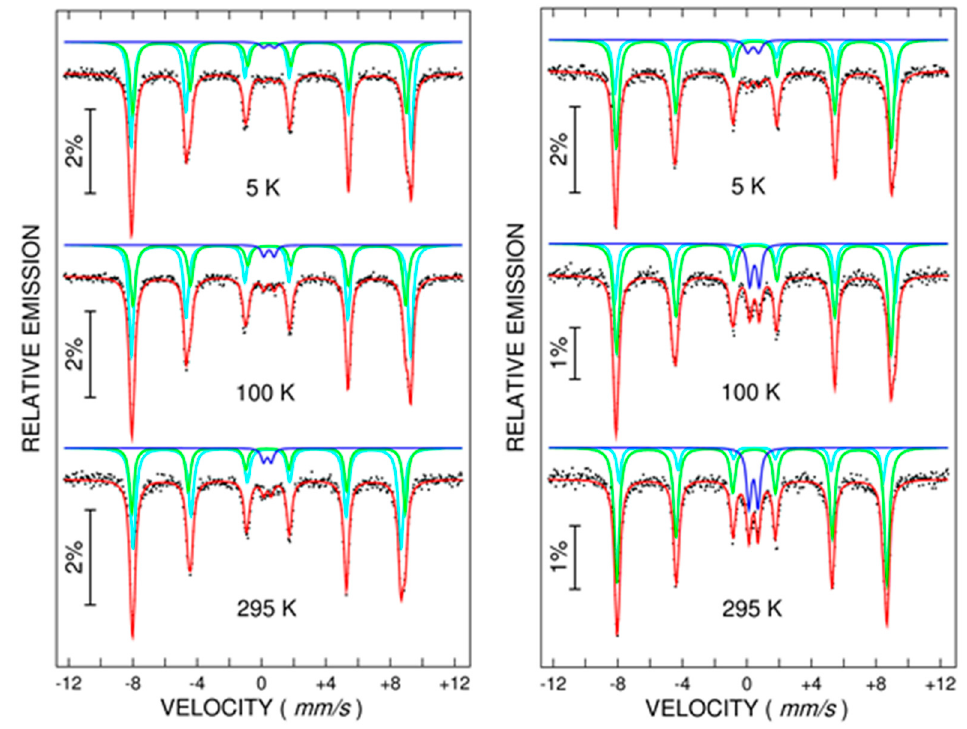
Figure 6. Temperature-dependent 57 Fe Mössbauer spectra recorded at 5, 100, and 295 K on the equimolar mixture MoO 2 -Fe 2 O 3 after 2 h (left side) and 8 h (right side) of milling time. equimolar mixture MoO 2 -Fe 2 O 3 after 2 h ( left side ) and 8 h ( right side ) of milling